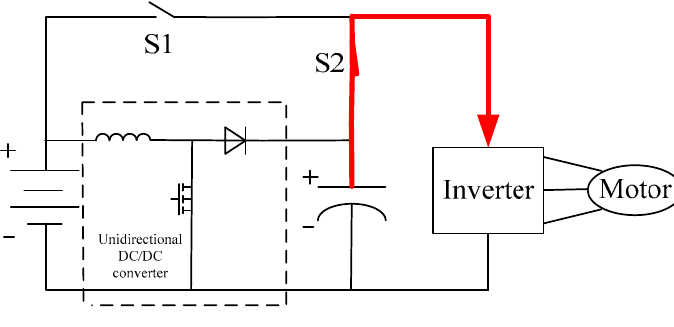
Figure 4. Mode 1—the SC acts as the unique power source.